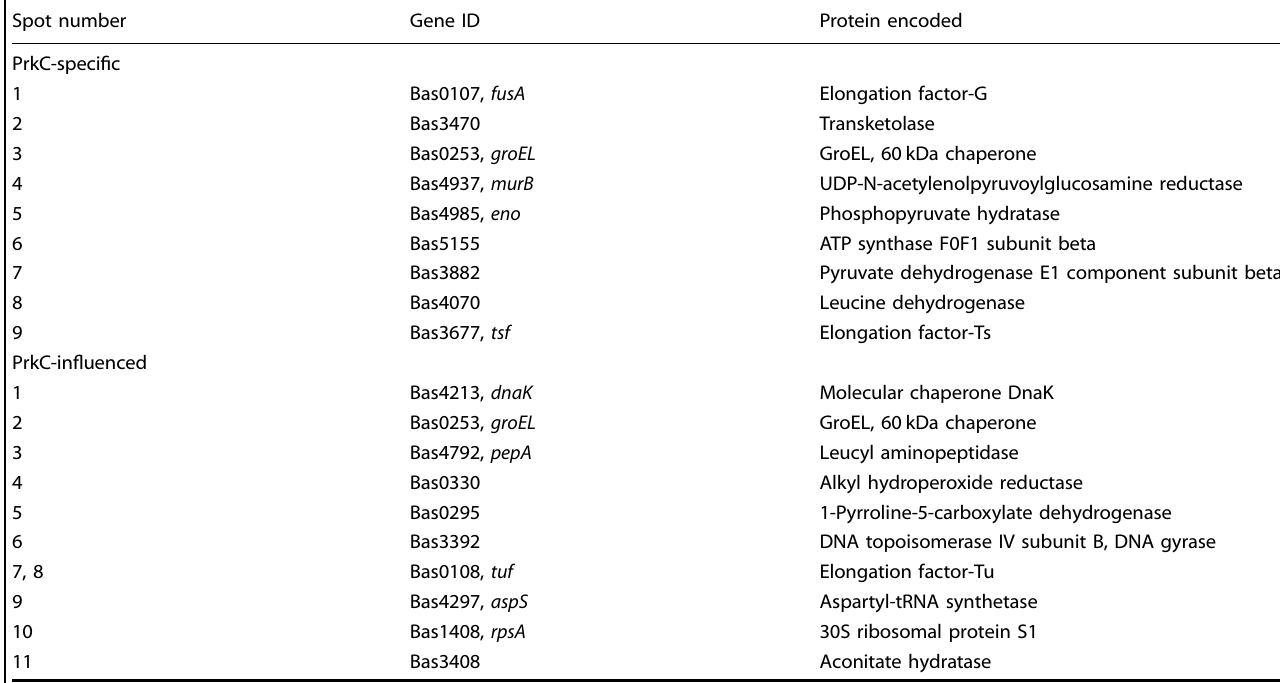
Table 1. Differentially phosphorylated proteins identi fi ed by mass spectrometry